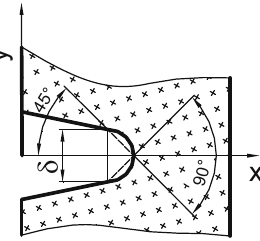
Figure 3: Shih ’ s concept [ 16 ] used to determine the crack tip opening